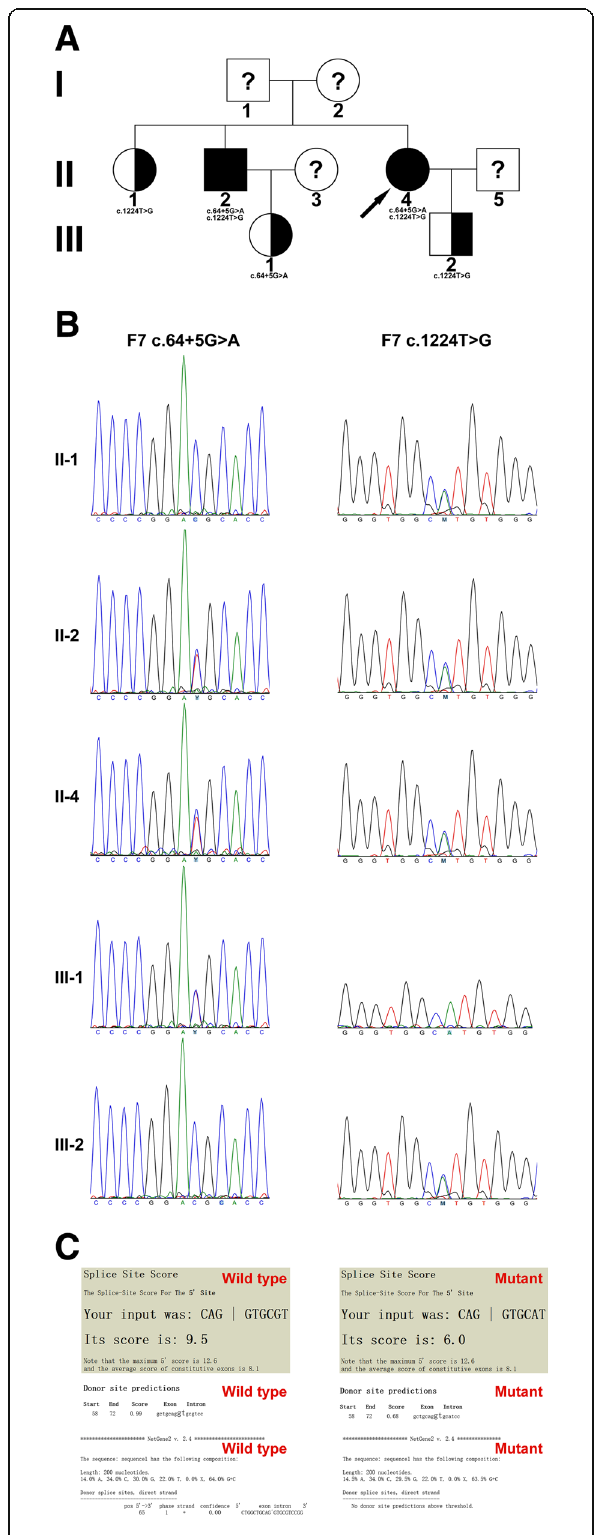
Fig. 2 Congenital factor VII (FVII) deficiency. a , The family tree of a Chinese family with HLH and congenital FVII deficiency. Square and circle denoted male or female respectively. Full-filled square and circle meant patients, and half-filled symbols represented heterozygous carrier. The arrow indicated the proband. A question mark meant that genetic analysis was unavailable. b , Sanger sequencing of F7 c.64+ 5G>A and c.1224 T>G mutations. c , Splicing site prediction by Splice Site Score Calculation (http://rulai.cshl.edu/new_alt_exon_db2/HTML/ score.html), Splice Site Prediction by Neural Network (http://www. fruitfly.org/seq_tools/splice.html), and Netgene2 (http://www.cbs.dtu.